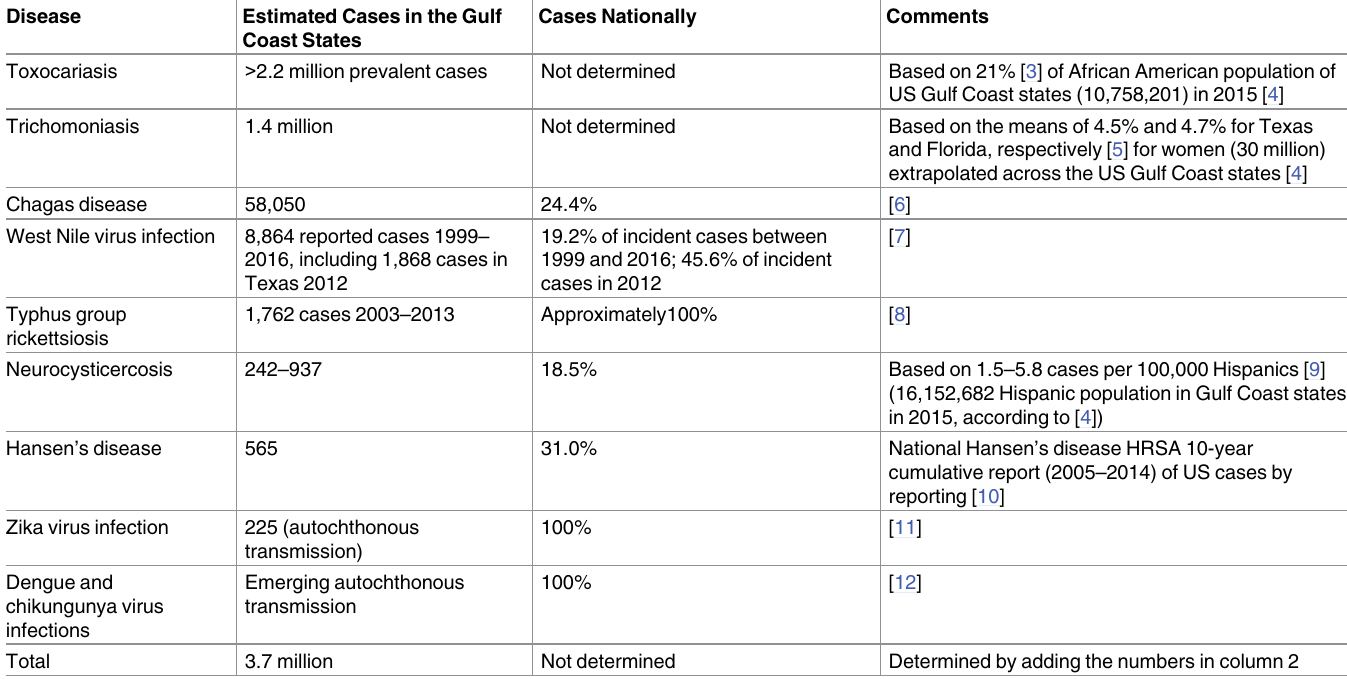
Table 1. Prevalence and incidence estimatesof the NTDs affecting the US Gulf Coast